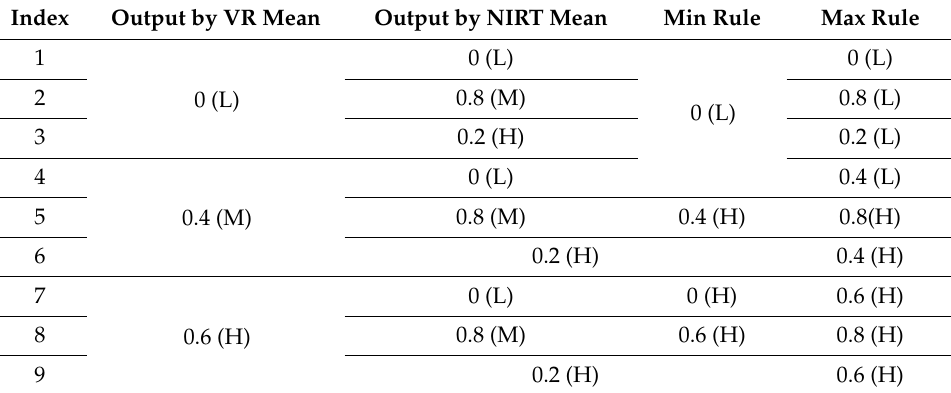
Figure 6. Example of calculating output value from input feature value input membership function: ( a ) Output value for VR mean; ( b ) Output value for NIRT mean. Table 2. Example of IVs obtained by Fuzzy rule, Min rule, or Max rule.